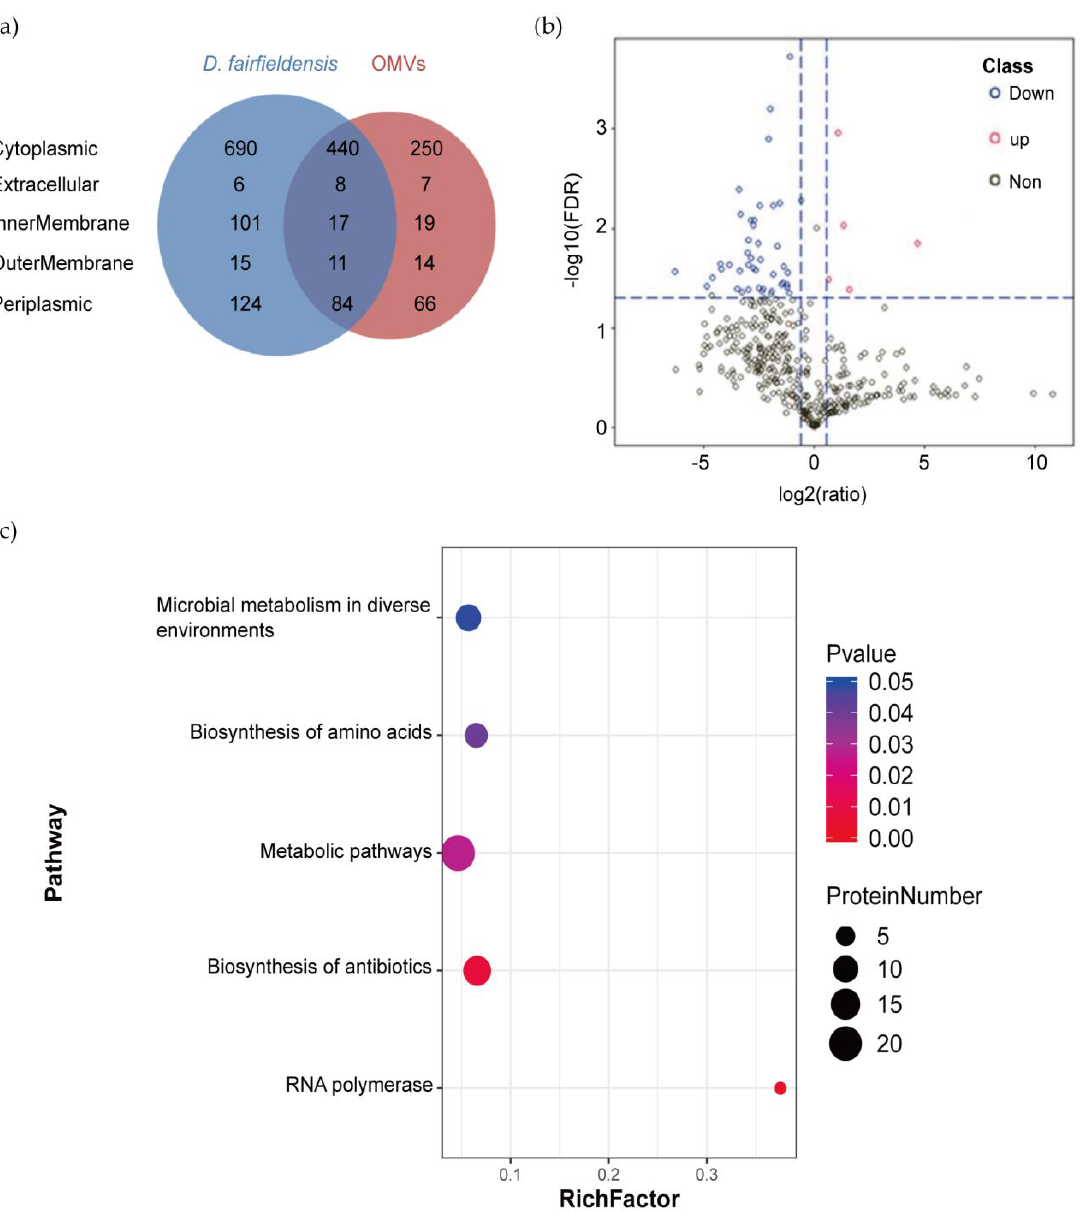
Figure 2. Proteomic analysis of D. fairfieldensis and its OMVs. ( a ) Venn diagram of proteins identified in OMVs and D. fairfieldensis . ( b ) Volcano plot of proteins expressed in D. fairfieldensis and its secreted OMVs. Red dots represent proteins significantly upregulated in OMVs, blues dots represent proteins significantly down-regulated in OMVs, and gray dots represent proteins without significant changes when compared with D. fairfieldensis . ( c ) Metabolic pathways enriched by differential proteins between OMVs and D. fairfieldensis . The X -axis enrichment factor (Rich Factor) is the number of differential proteins annotated to the pathway divided by all the proteins identified in the pathway. The larger the value, the greater the proportion of differential proteins to the pathway annotation. The dot size in the figure represents the number of differential proteins annotated to the